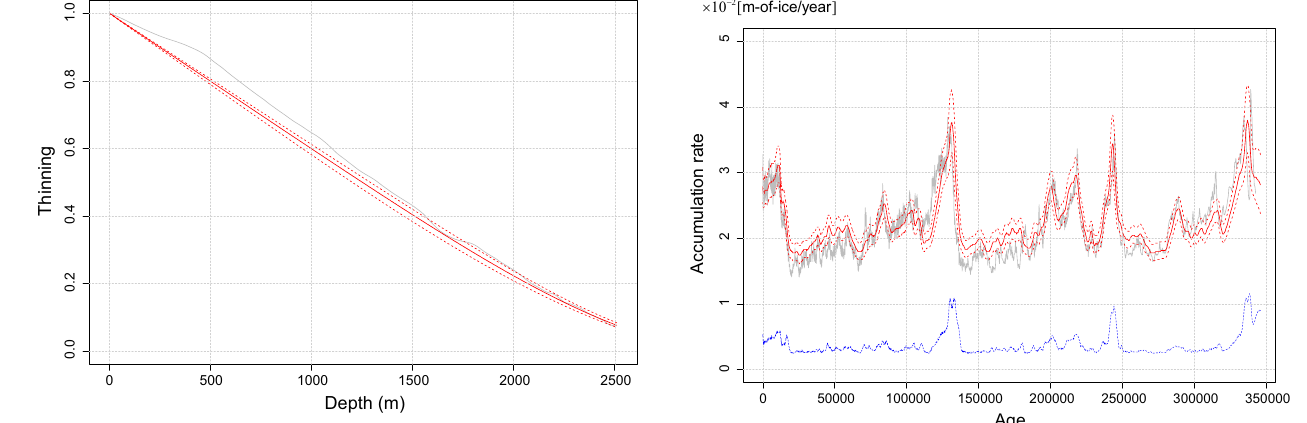
Figure 8. Estimated accumulation rate as a function of age. The median of the posterior is indicated by a red solid line, the 10th and 90th percentiles are indicated by red dotted lines, the difference between the 10th and 90th percentiles is indicated by a blue dotted line, and the estimate by Parrenin et al. (2007) is indicated by a grey